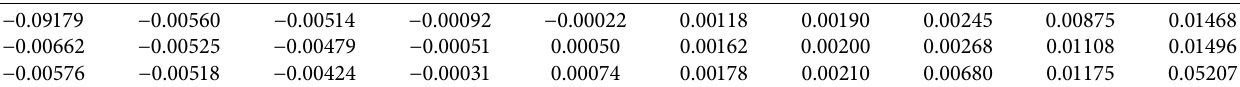
Table 3: Te DAX data.